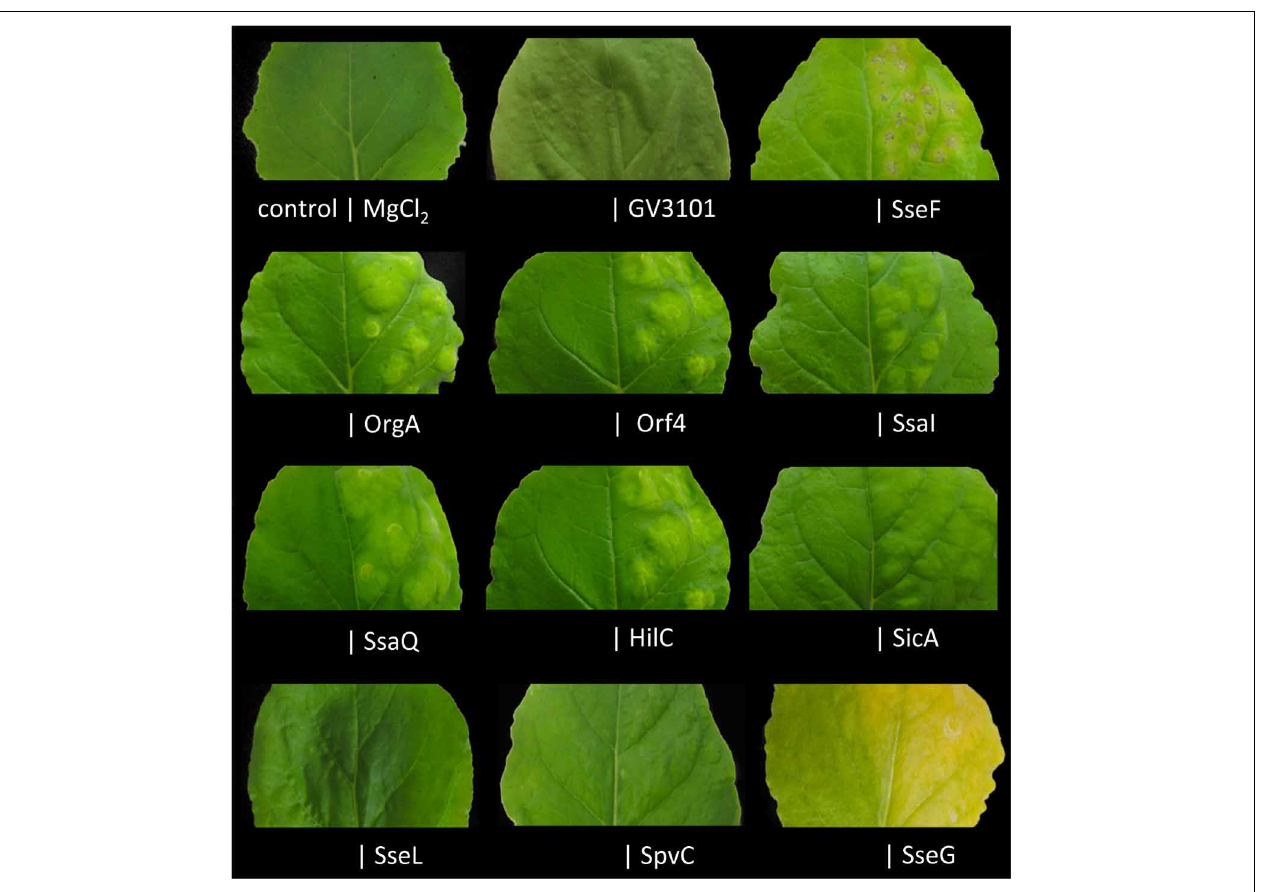
FIGURE 1 | Screen for Salmonella proteins that induce HR-like symptoms in plants. SVF and effector genes were cloned into plant expression vectors and expressed as HA- and Myc-tagged versions in N. benthamiana leaves via Agrobacterium -mediated transformation. Symptoms were observed 5 days after infiltration. Expression of eight proteins resulted